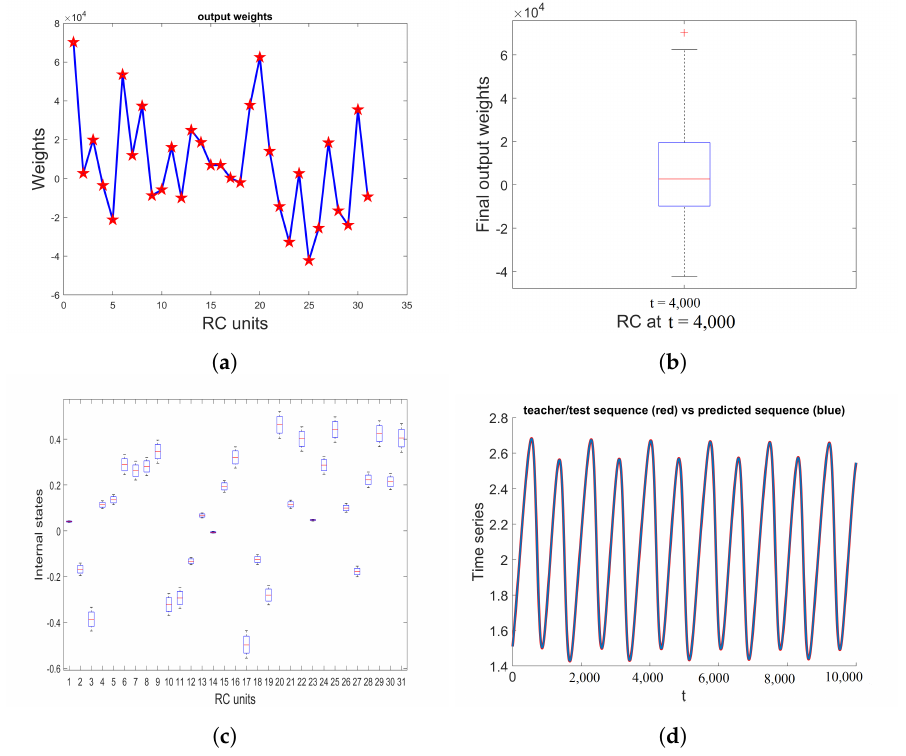
Figure 12. Similar to Figure 4 but for the case where σ =